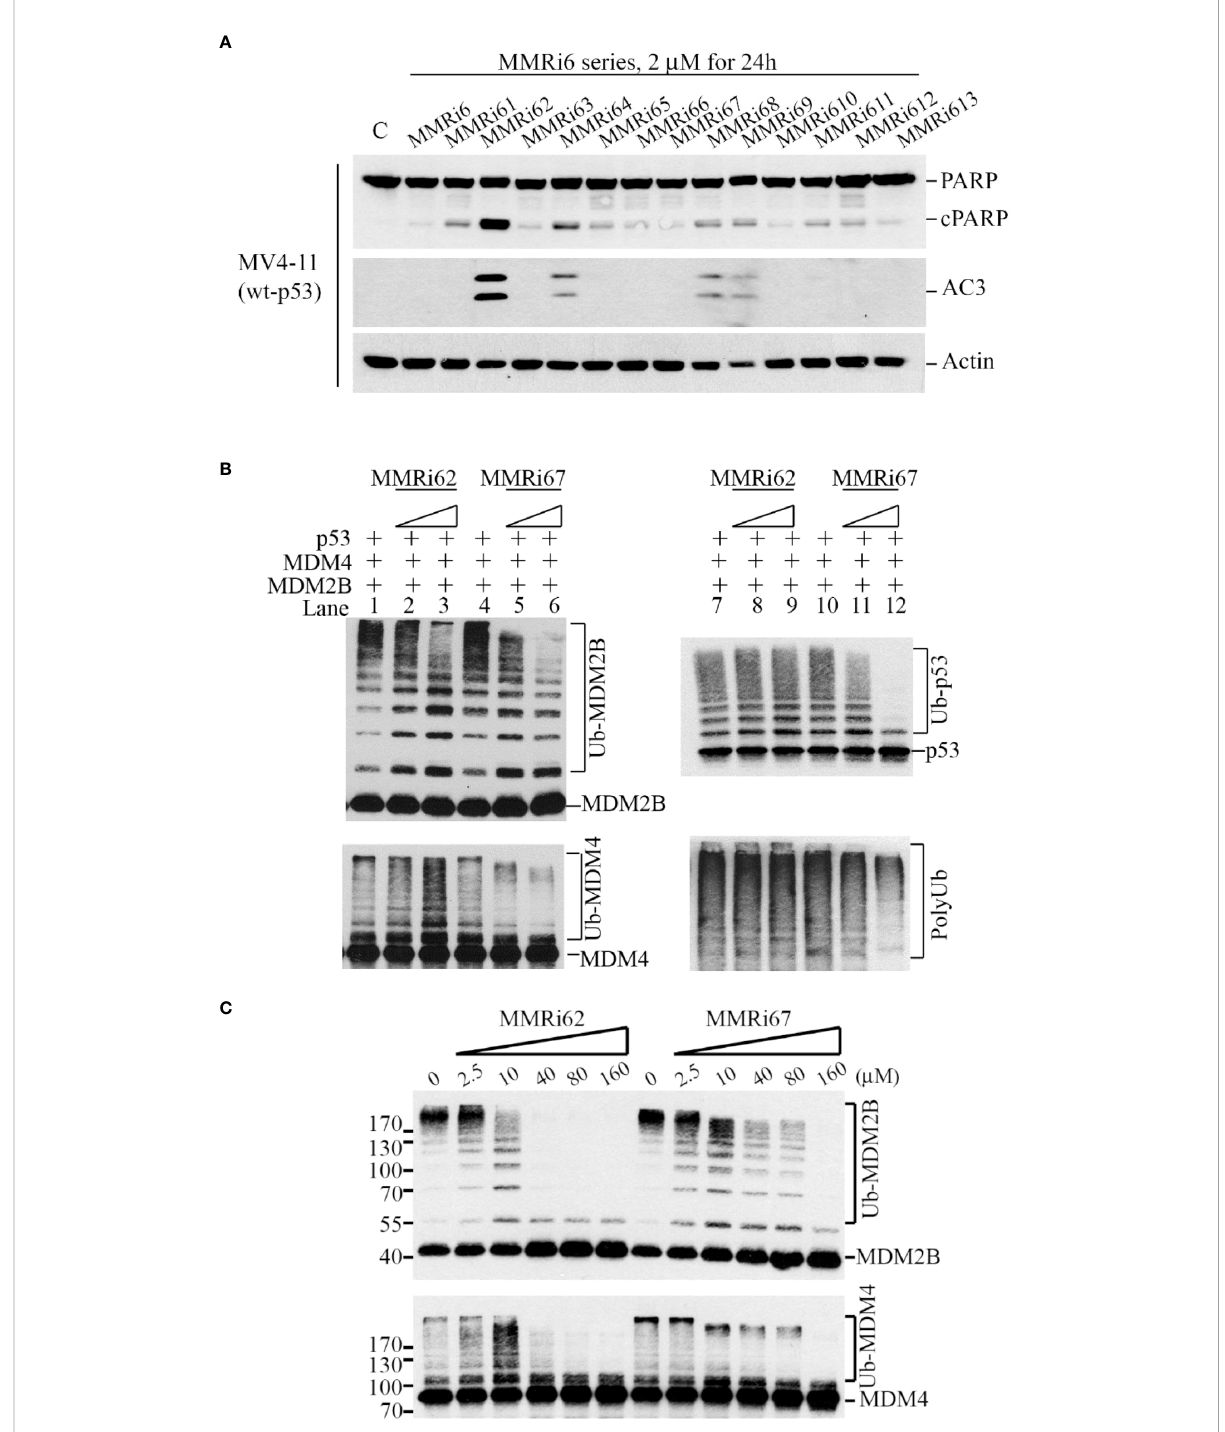
FIGURE 1 Identi fi cation of MMRi62 as an apoptosis inducer and MMRi67 as E3 ligase inhibitor by apoptosis and E3 ligase inhibitor screens. (A) Apoptosis screen of MMRi6 analogs by activated caspase 3 (AC3) and cleaved PARP as readouts using wt-p53 bearing MV4-11 cells treated with 2 m M of MMRi6 analogs for 24 h. (B) In vitro ubiquitination assay using recombinant MDM2B, MDM4, and p53 proteins in the presence of the solvent dimethyl sulfoxide (DMSO) or MMRi6 analogs (0, 5, and 10 m M of MMRi62 or MMRi67); ubiquitinated species of MDM2B, MDM4, p53, and polyubiquitin are shown. (C) In vitro ubiquitination assays as performed in panel B using MDM4 and MDM2B with an extended range of concentrations of MMRi62 and MMRi67; ubiquitinated species of MDM2B and MDM4 are